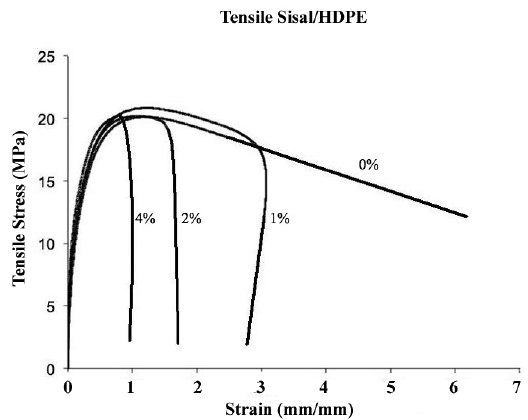
Figure 6. Tensile stress-strain average curves of HDPE/Sisal composites with different fiber percentages.